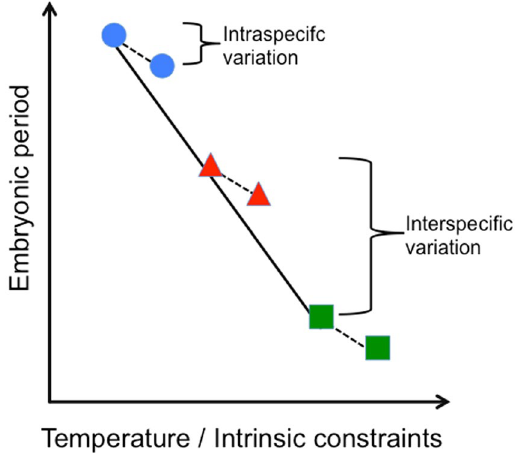
Figure 1. Conceptual graph representing the potential effect of temperature on embryonic development. Each symbol and color represents a different species. At the intraspecific level, temperature (dashed lines) can explain small differences in development period (small bracket). However it is unclear if temperature (solid lines) or physiological constraints are the main determinant of the larger interspecific differences in embryonic period (large